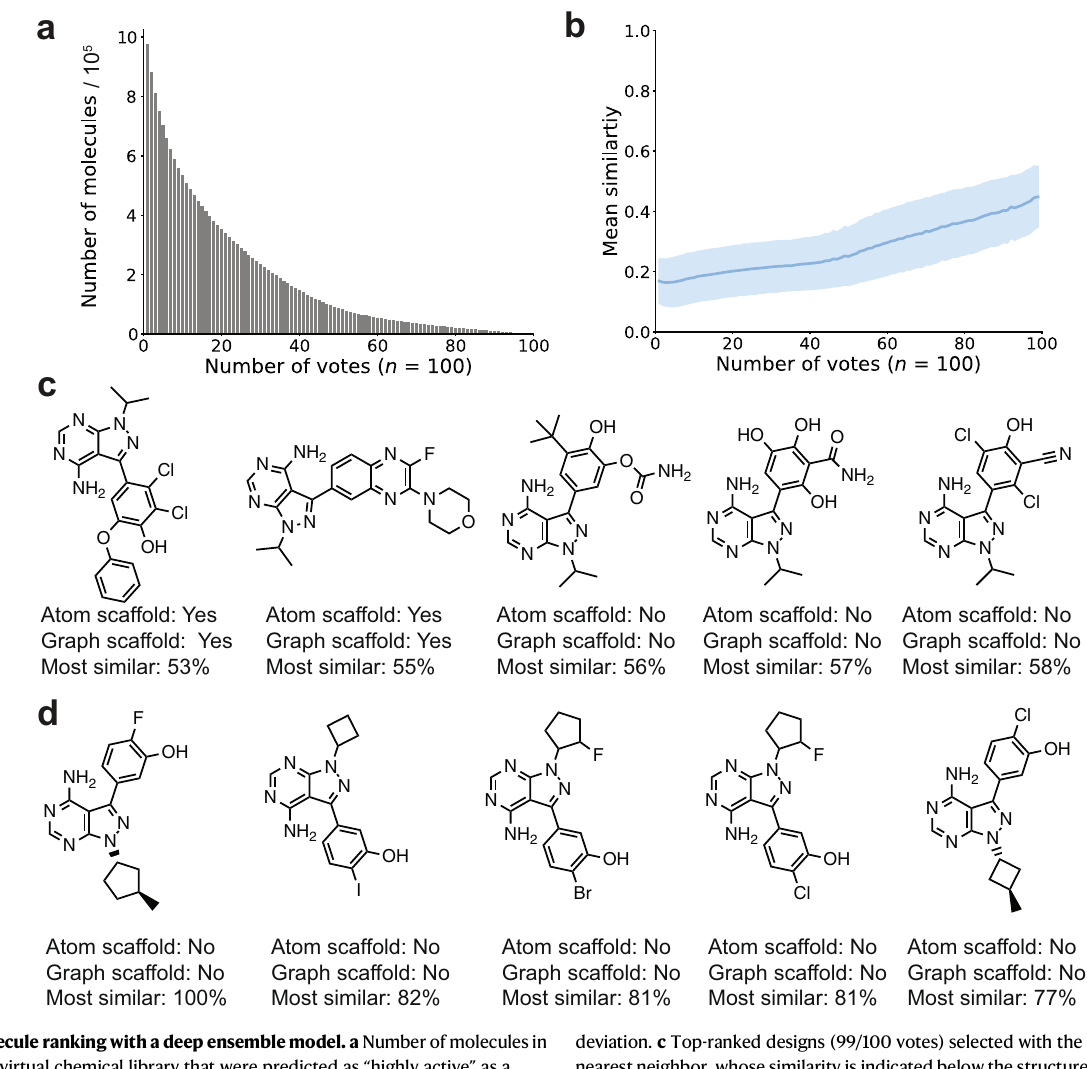
deviation. c Top-ranked designs (99/100 votes) selected with the most distant nearestneighbor,whosesimilarityisindicatedbelowthestructure( “ Mostsimilar ” ) in the fi ne-tuning set. The atom ( “ Atom scaffold ” ) and graph ( “ Graph scaffold ” ) scaffold novelty of the structure with respect to the fi ne-tuning set is indicated below each structure ( “ Yes ” : new, “ No ” : not new). d Top-ranked designs (99/100 votes) selected with the closest nearest neighbor in the fi ne-tuning